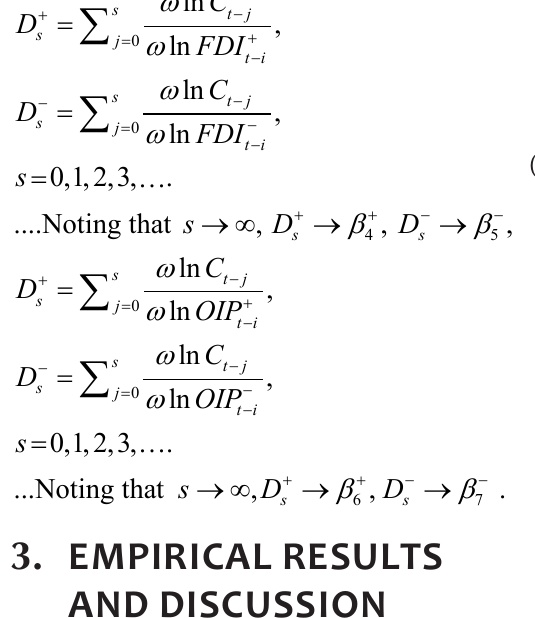
Table 2. F-Bound test for linear cointegration